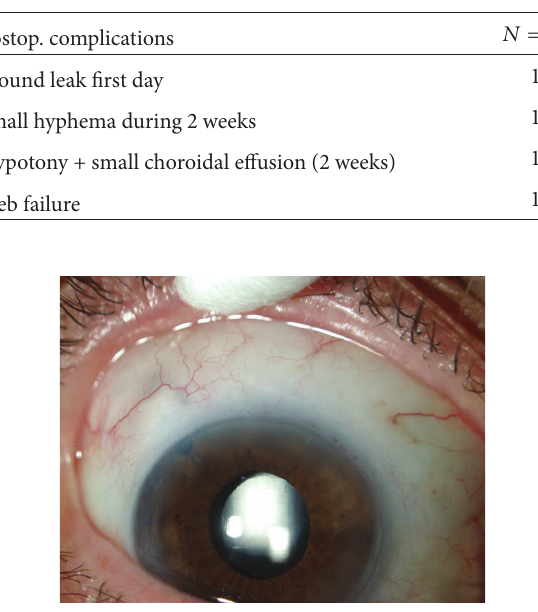
Figure 2: Postoperative view of trabeculectomy with iridenflip and diffuse bleb superotemporal.